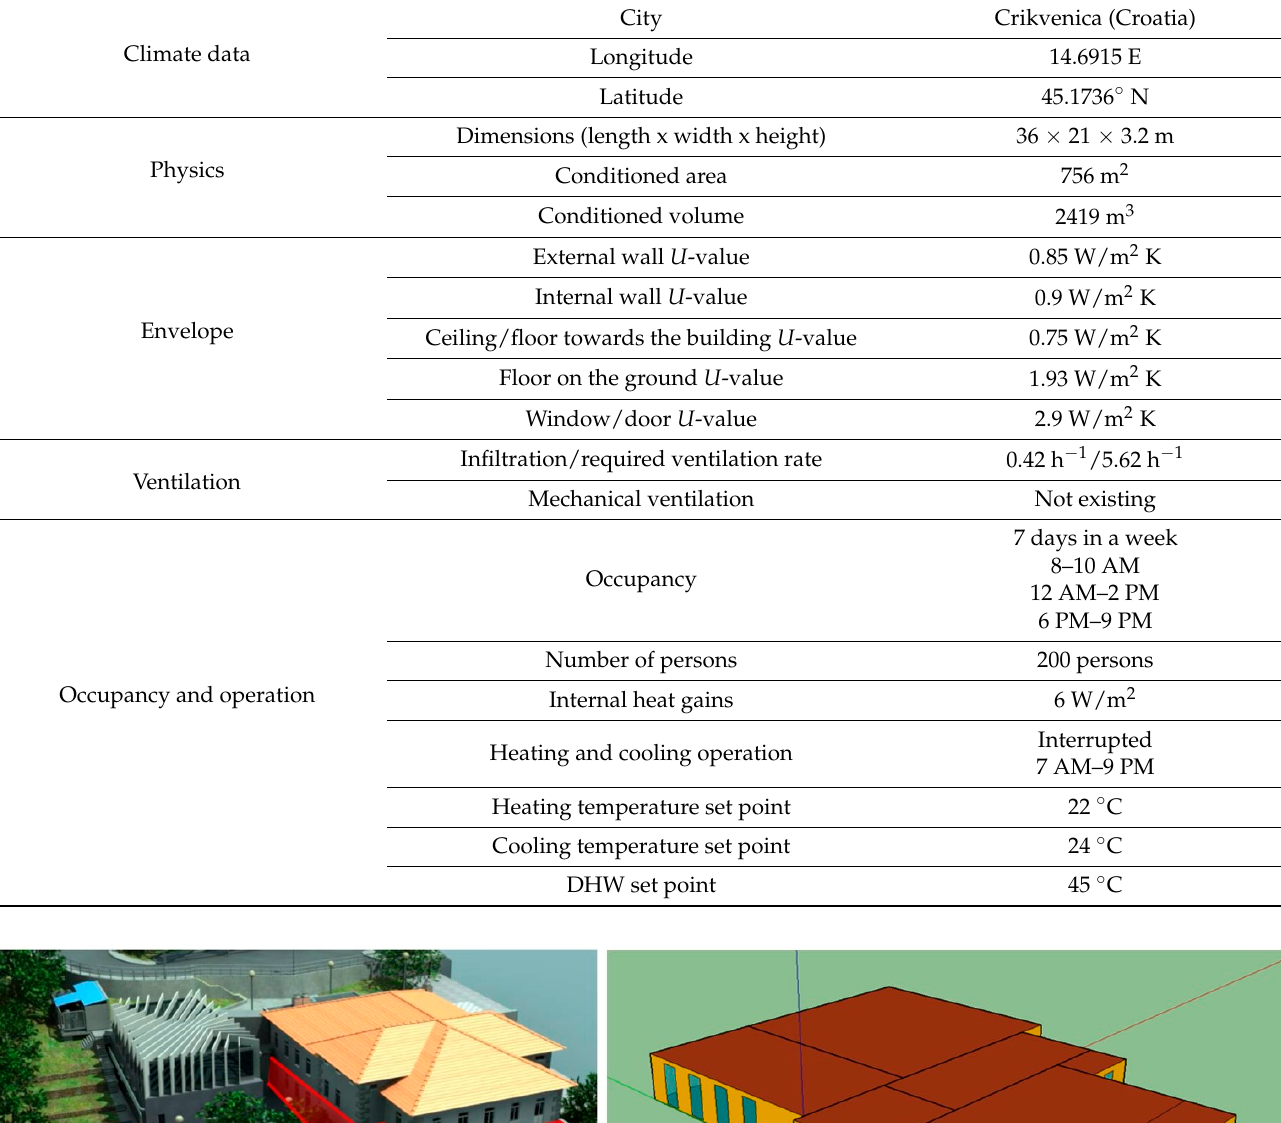
Table 1. Main characteristics of the building regarding physics, operation, and climate data.